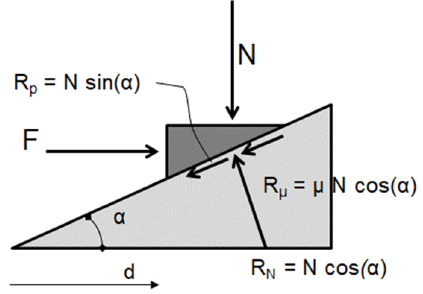
Figure 2. Mechanical model of a rigid block on sloped surface. The horizontal movement of the beam, with respect to the column head caused from a horizontal action F, e.g., a seismic action, triggers the sliding of the convex plate on